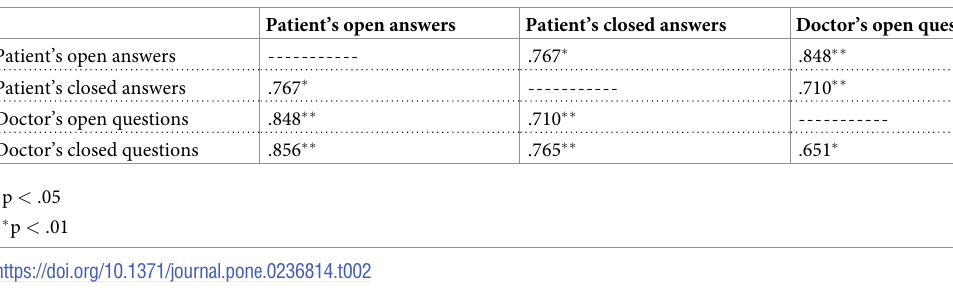
Table 2. Bivariate correlations among doctor’s questions and patient’s